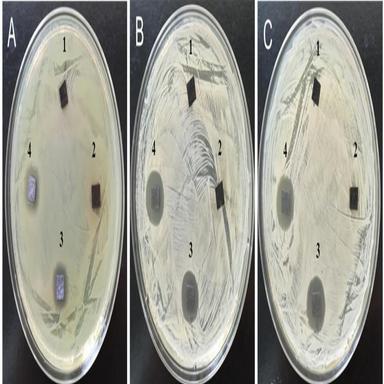
Antibacterial effect of filtering paper covered with PPy (1), PPy–Au (2), PPy–Ag (3,4) against: A – P. aeruginosa, B – S. aureus, C – E. coli.